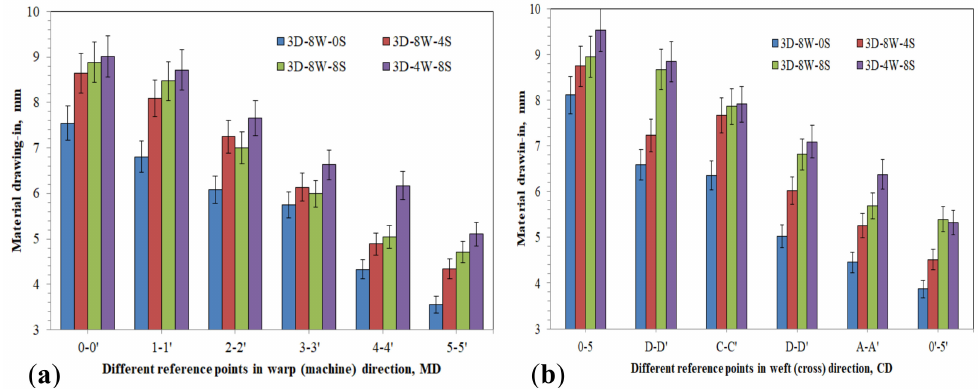
Figure 11. Influences of warp yarn system on the drawing-in values of 3D warp interlock preform at di ff erent points in the machine ( a ) and cross ( b )